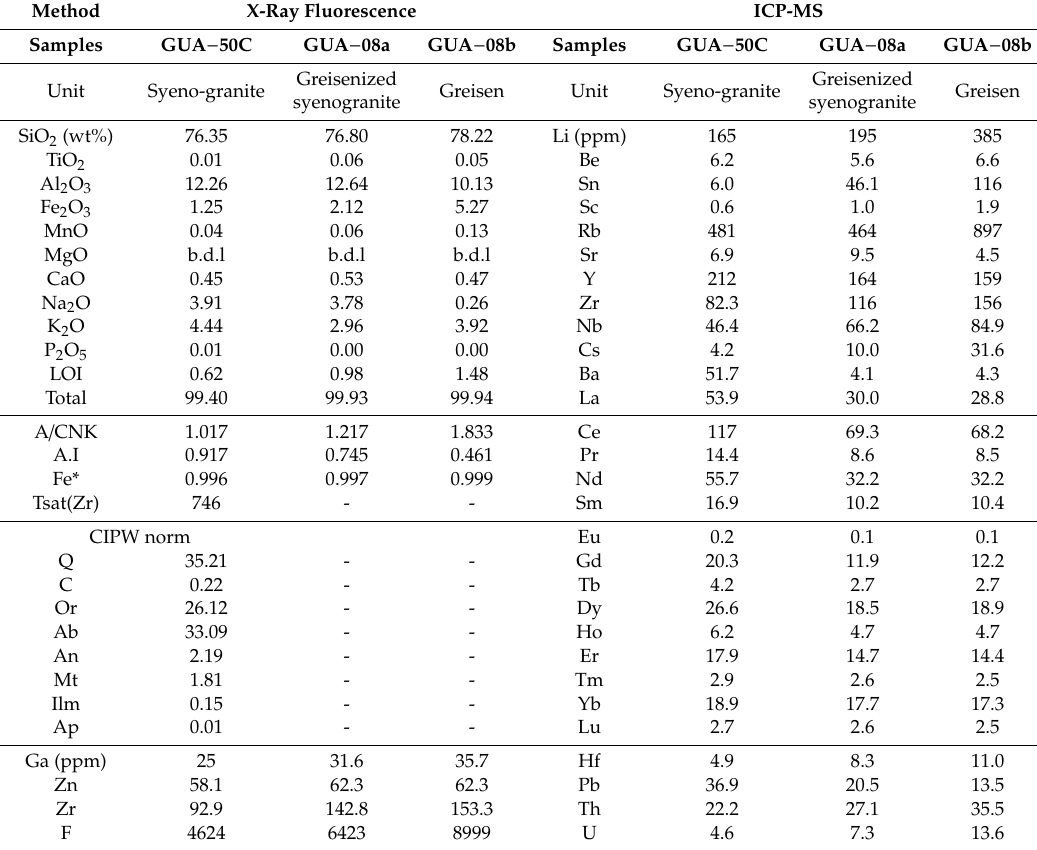
Table1. ChemicalanalysesforthestudiedDesemborqueRocks. Major(X-rayfluorescencespectrometry) and trace element (ICP-MS Inductively coupled plasma mass